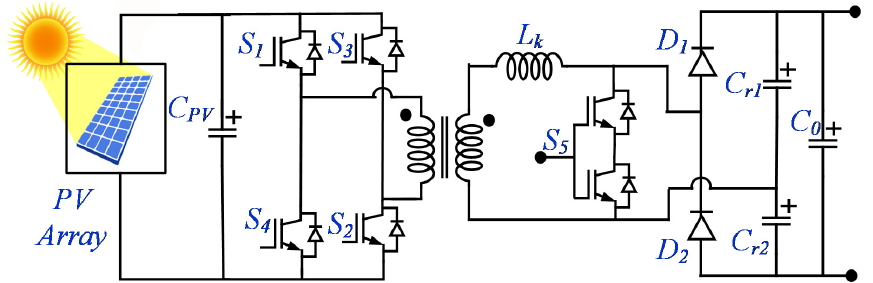
Figure 34. Hybrid resonant DC–DC converter with soft switching.